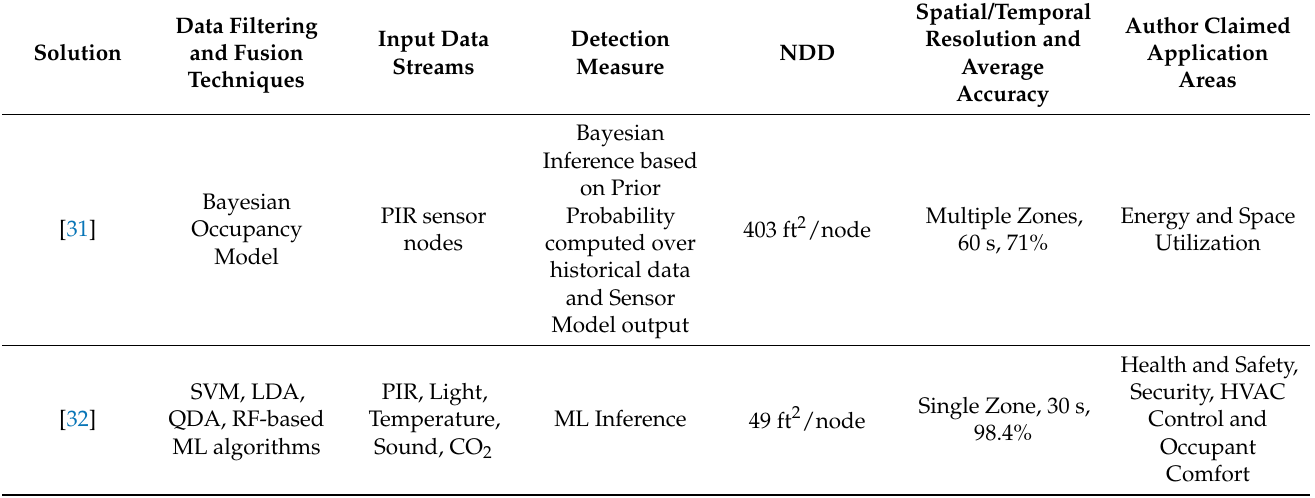
Table 4. Reviewed solution details and claimed application